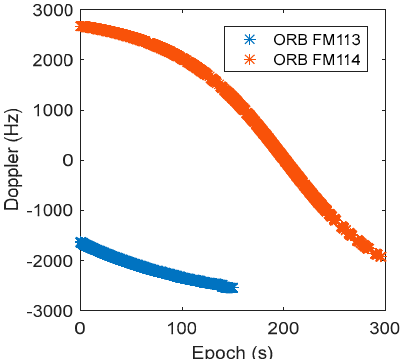
Figure 8. Doppler collected by the user station.